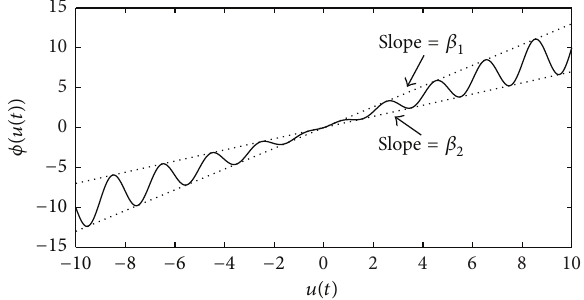
Figure 2: A scalar nonlinear function 𝜙(𝑢) inside sector [𝛽 1 𝛽 2 ]